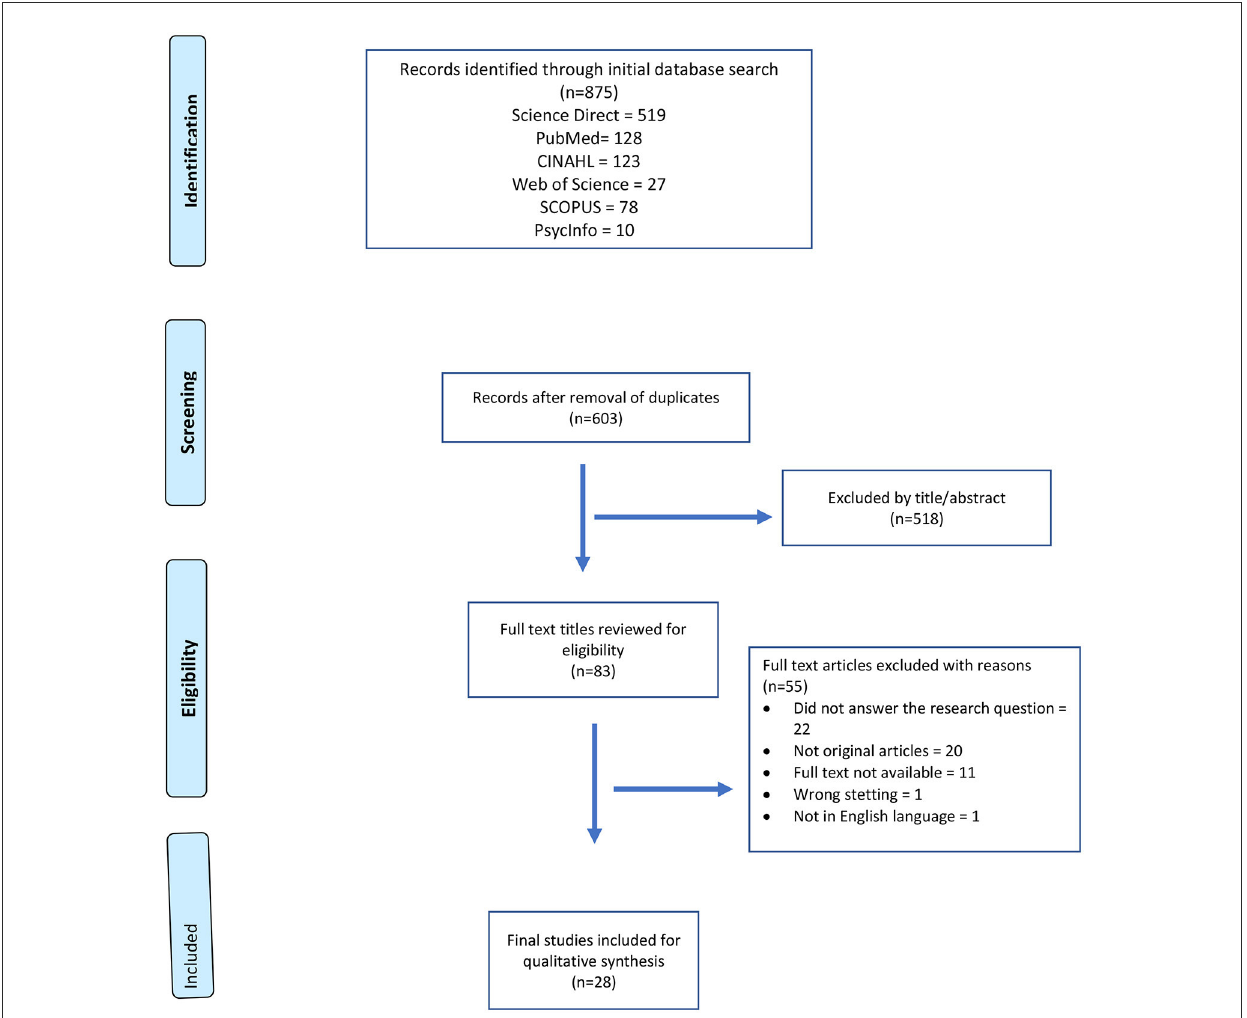
FIGURE1 A flow chart for the selection of the studies about physicians’ psychological health and personal and professional wellbeing in COVID-19 using the Preferred Reporting Items for Systematic Reviews and Meta-analyses (PRISMA)